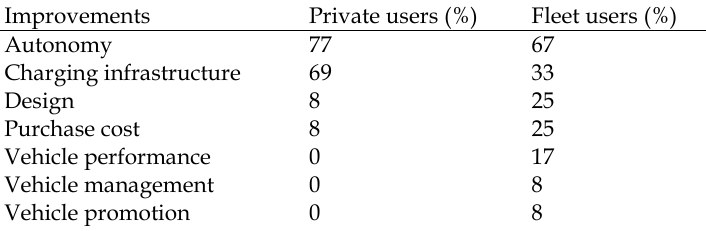
Table 6 Expected EV improvements according to private and fleet users (percentage of